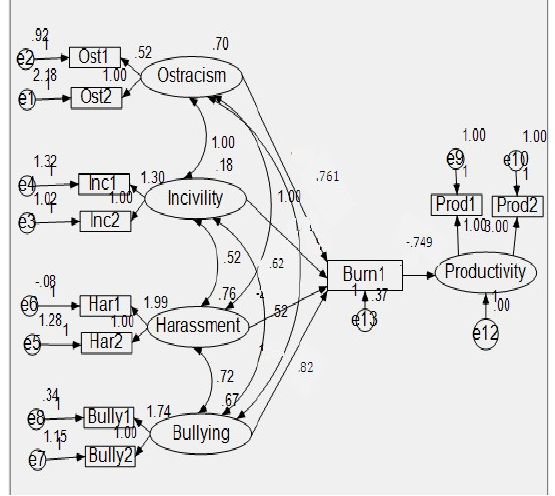
Figure 2. Path Analysis ‐ II.